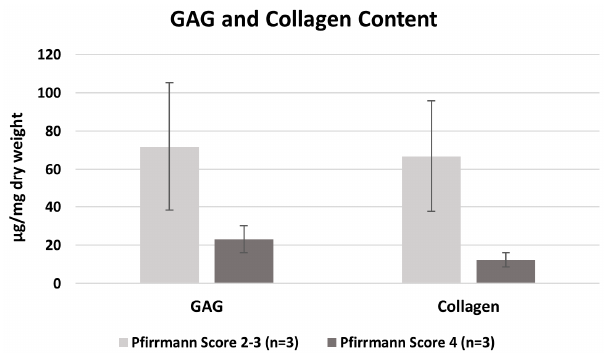
Figure 3. Glycosaminoglycan (GAG) and collagen content of mild (Pfirrmann score 2–3) and severe (Pfirrmann score 4) degenerated native annulus fibrosus (AF) tissues (error bars SEM).